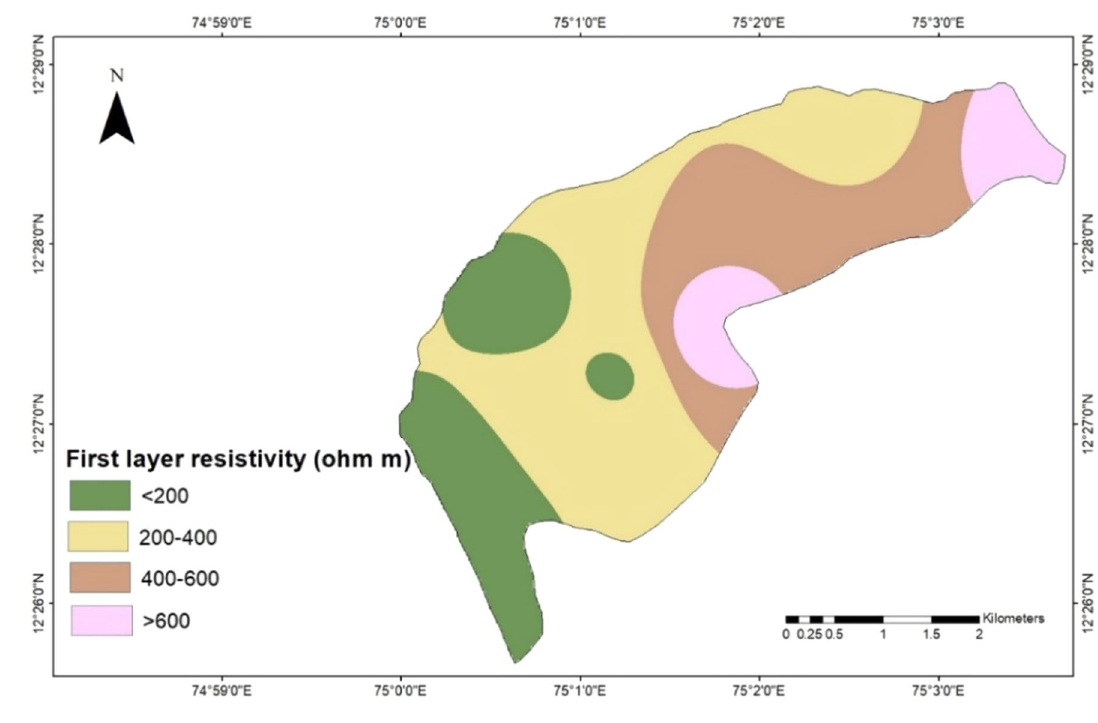
Fig. 4 Spatial variation map of first layer apparent resistivity (ohmm)